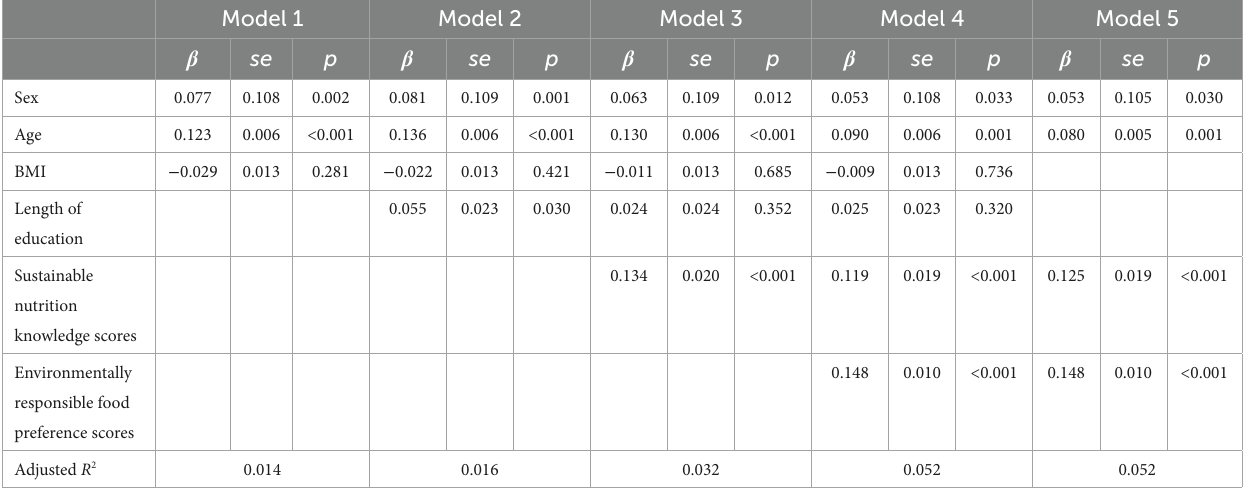
TABLE 3 Regression models for potential factors affecting adherence to the Mediterranean